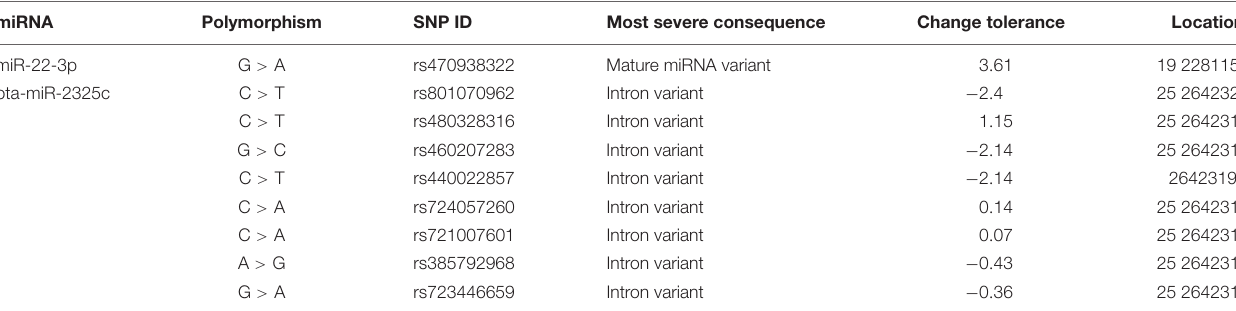
FIGURE 8 | Bar chart representing the number of genes indicated in each of the significant and specific immune-related pathways found using GO and GeneAnalytics. TABLE 5 | Information pertaining to the variants found for miR-22-3p and miR-2325c when compared to the cow